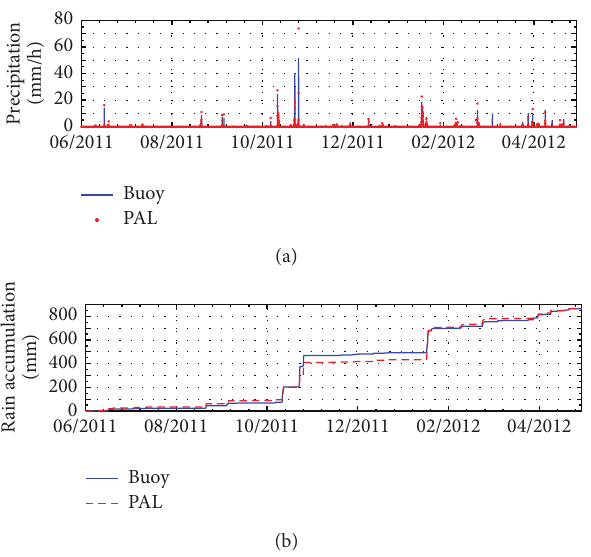
Figure 8: (a) Time series of rain rates and (b) rain accumulation throughout the whole experimental period acquired by the rain gauge on board the buoy and derived from the acoustic noise col- lected by the Passive Aquatic Listener.